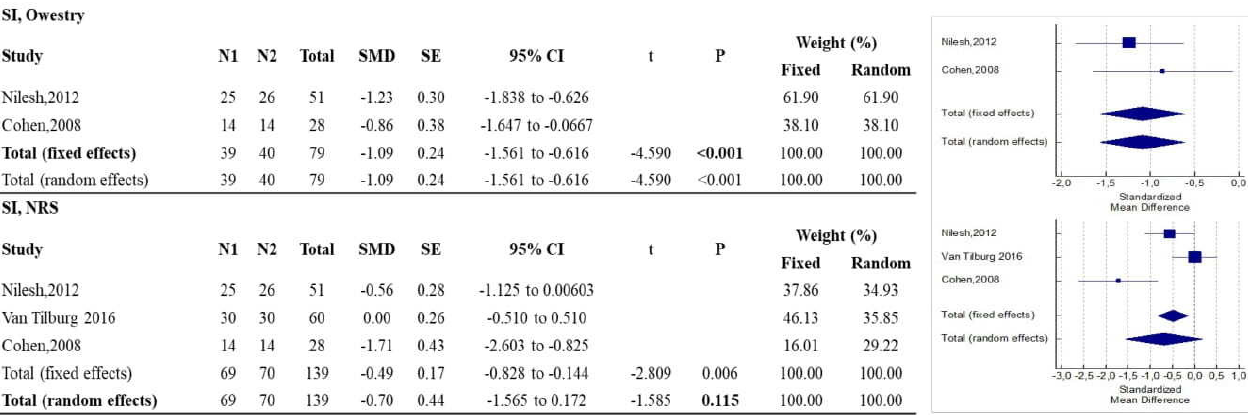
Figure 3. Forest plots showing intervention effects on the sacroiliac Owestry and NRS outcomes. The use of fixed or random effects (bold) is chosen based on the results of the Higgins’ heterogeneity test. Note: N1 = no. of patients in the intervention group; N2 = no. of patients in the control group; SMD = standardized mean difference; CI = confidence interval .